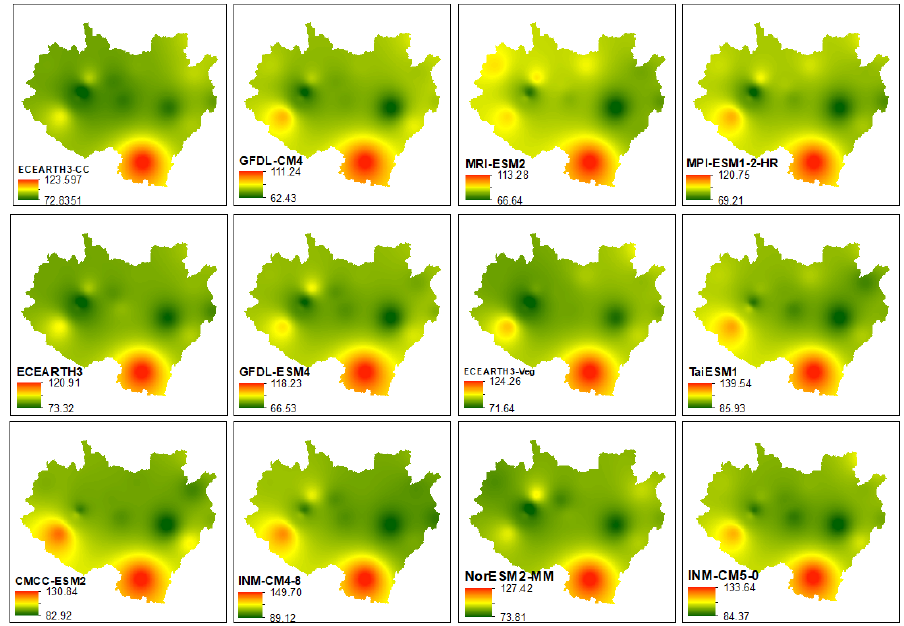
Figure 12. Maps of IDW interpolated the monthly precipitation RMSE values of the 12 climate